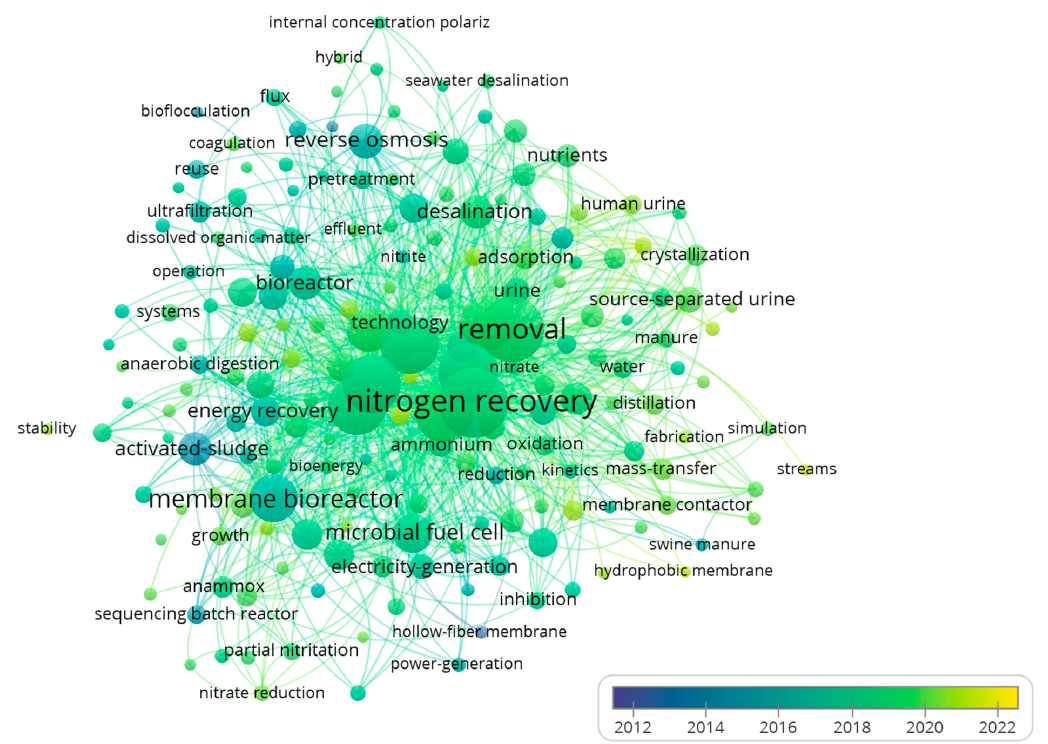
Figure 3. Keywords co-occurrence map.